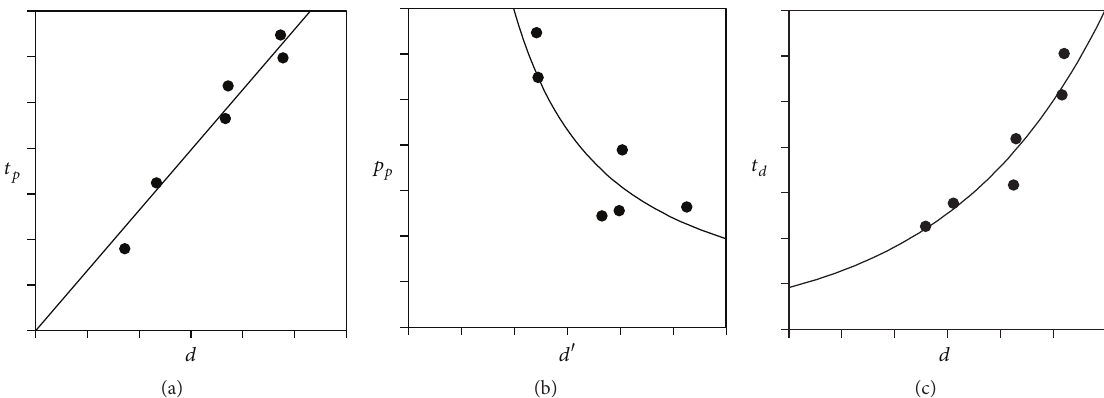
Figure 4: Illustration of experimental values and trend lines for arrival time of shock wave 𝑡 𝑝 (a), peak overpressure 𝑝 𝑝 (b), and duration of positive pressure phase 𝑡 𝑑